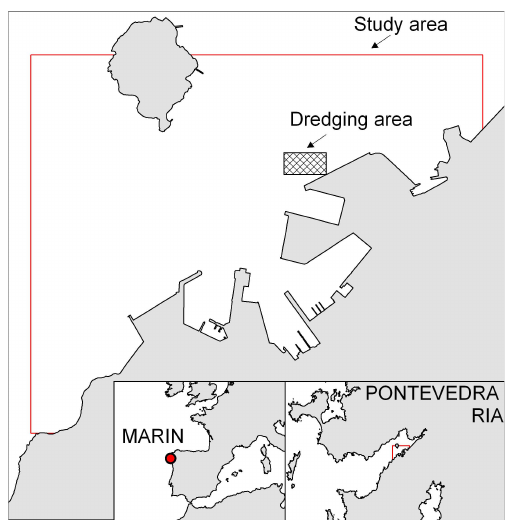
Fig. 2. Location of the Port of Marin and the dredging area.